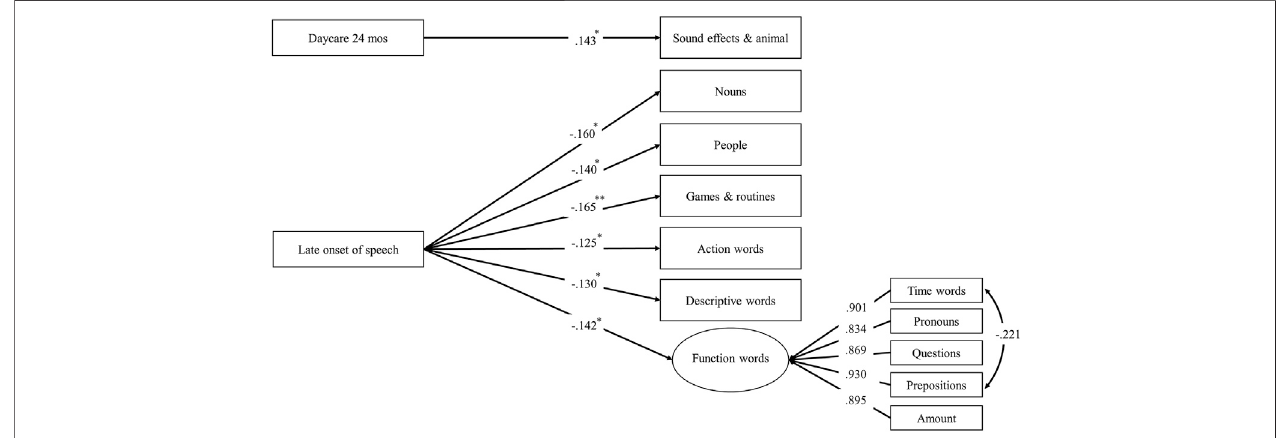
FIGURE 3 | Structural equation model including signi fi cant factors in predicting vocabulary growth in lexical categories in boys between ages 13 and 24 months. Note ( n (cid:1) 245); χ 2 (60) (cid:1) 122.29, p < 0.001, RMSEA (cid:1) 0.065, CFI (cid:1) 0.9813, TLI (cid:1) 0.958, SRMR (cid:1) 0.016; Standardized coef fi cients. ** p < 0.001, * p < 0.05.